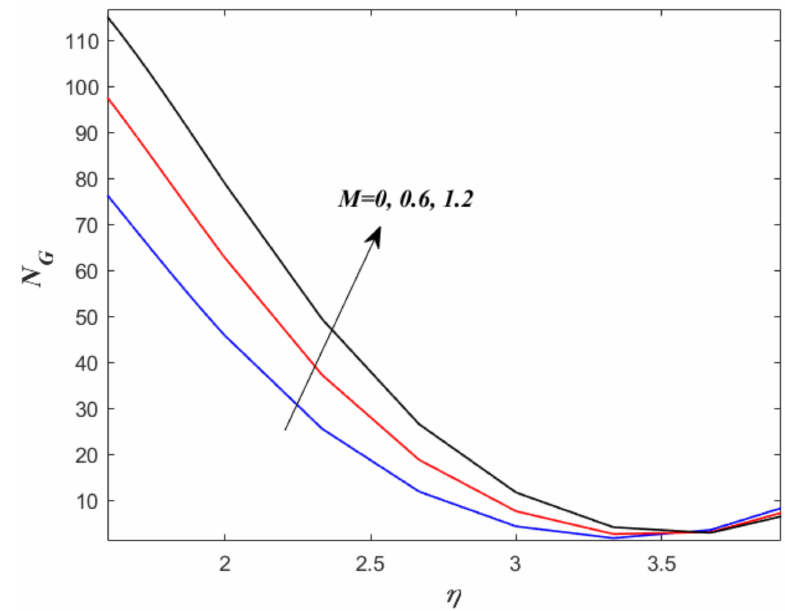
Figure 9. Various values of magnetic parameter ( M ) on N G